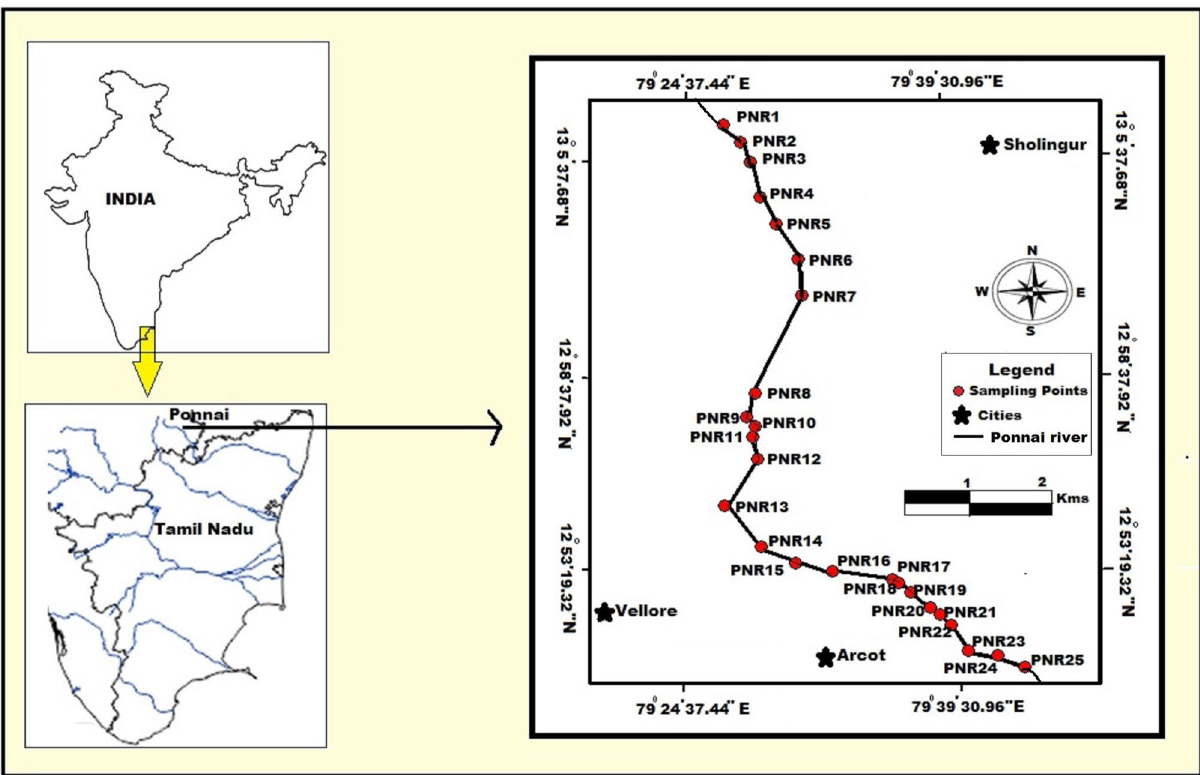
Figure 1. Sampling locations in Ponnai River, Tamilnadu (Map drawn using the software “MapInfo Professional version